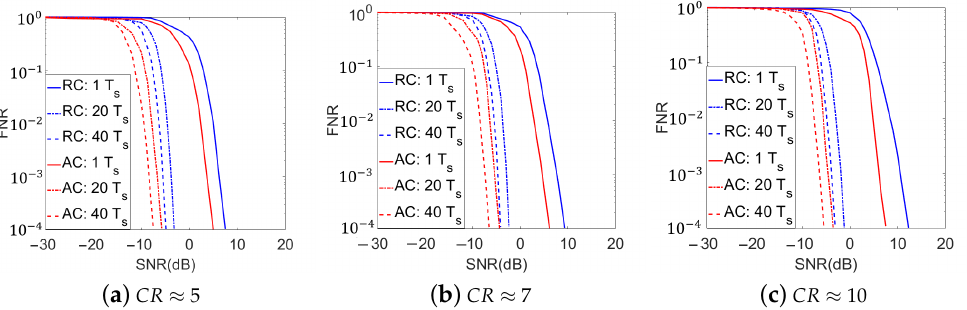
Figure 9. Simulated Detection Accuracies over Multiple Symbol Periods with the Single Neural Network Strategy for the Proposed Adaptive Method (RC: Conventional compressive detection with random measurement kernels; AC: Adaptive compressive detection with the single neural network strategy. T s represents the time of one symbol